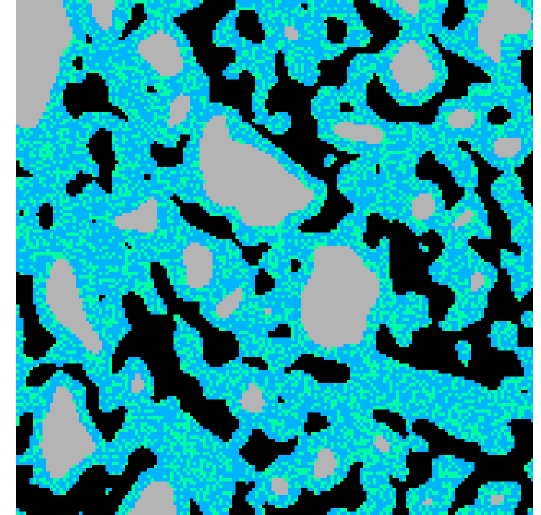
Figure 5. Thresholded 2D slice of the tomo- graphic data separating cement (clinker+calcium sul- fate phases), amorphous and crystalline hydrates, and capillary porosity; image size 158 × 158 pixels captur- ing an area 150 × 150 µm 2 ; color map corresponds to Figure 3. slices, as described